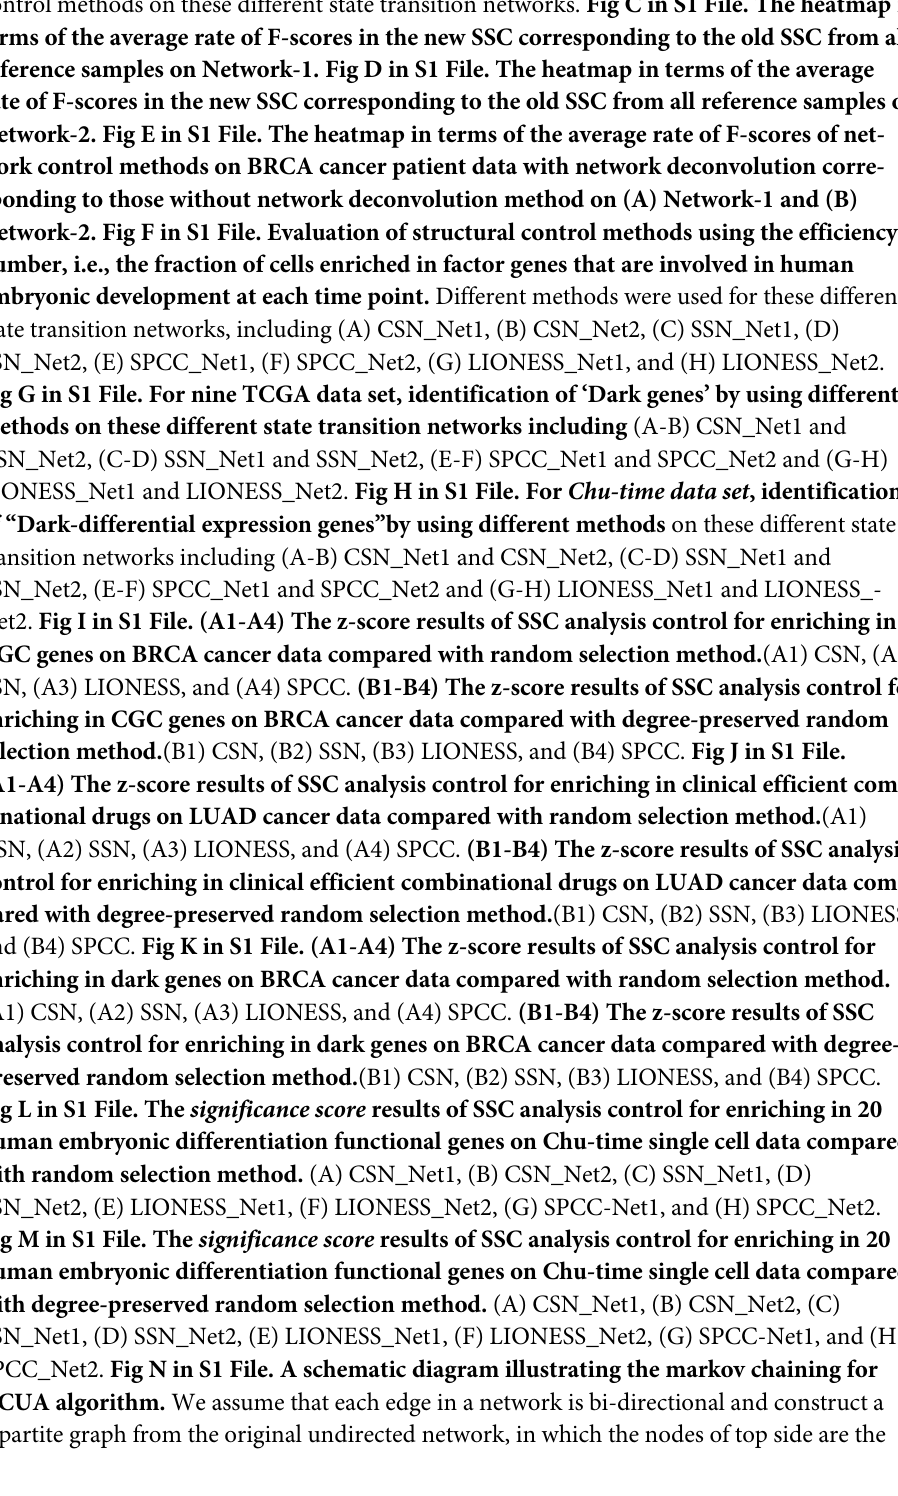
Fig L in S1 File. The significance score results of SSC analysis control for enriching in 20 human embryonic differentiation functional genes on Chu-time single cell data compared with random selection method. (A) CSN_Net1, (B) CSN_Net2, (C) SSN_Net1, (D) Fig M in S1 File. The significance score results of SSC analysis control for enriching in 20 human embryonic differentiation functional genes on Chu-time single cell data compared with degree-preserved random selection method. (A) CSN_Net1, (B) CSN_Net2, (C) SPCC_Net2. Fig N in S1 File. A schematic diagram illustrating the markov chaining for NCUA algorithm. We assume that each edge in a network is bi-directional and construct a bipartite graph from the original undirected network, in which the nodes of top side are